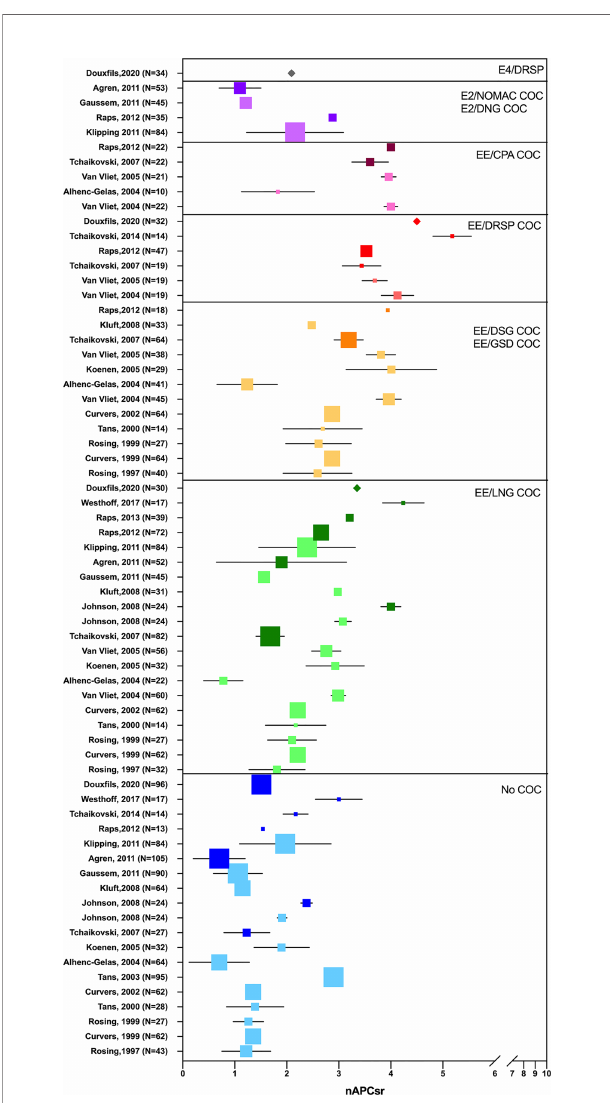
FIGURE 5 | Synthesis of studies from 1997 to 2020 investigating the impact of oral contraceptives on the activated protein C (APC) resistance, when expressed as normalized APC sensitivity ratio (nAPCsr). The X-axis represents nAPCsr in absolute values and the Y-axis represents the studies included ( fi rst author, year, sample size). Studies are cited multiple times depending on the investigated combined oral contraceptives. Blue squares represent nAPCsr values (± SD) for “ no-COC user ” group; green squares represents nAPCsr values (± SD) for “ EE- LNG user ” group; orange squares represents nAPCsr values (± SD) for “ EE-DSG and EE-GSD user ” group; red squares represents nAPCsr values (± SD) for “ EE- DRSP user ” group; pink squares represents nAPCsr values (± SD) for “ EE-CPA user ” group; purple squares represents nAPCsr values (± SD) for “ E2/NOMAC or E2/DNG user ” group and the grey square represents nAPCsr value (± SD) for “ E4/DRSP user ” group. The size of the square is related to the sample size. The clearest square are chromogenic-based ETP-based APC resistance studies and the darkest ones are calibrated automated thrombogram-based studies. The validated and standardized ETP-based APC resistance assay is represented by a diamond. APC, activated protein C; COC, combined oral contraceptive; CPA, cyproterone acetate; DSG, desogestrel; DNG, dienogest; DSPR, drospirenone; EE, ethinylestradiol; E2, estradiol; GSD, gestodene; LNG, levonorgestrel; nAPCsr, normalized activated protein C sensitivity ratio; NOMAC, nomegestrol acetate; SD, standard